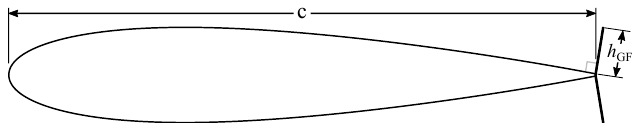
Figure 1. Double Gurney flap geometry and